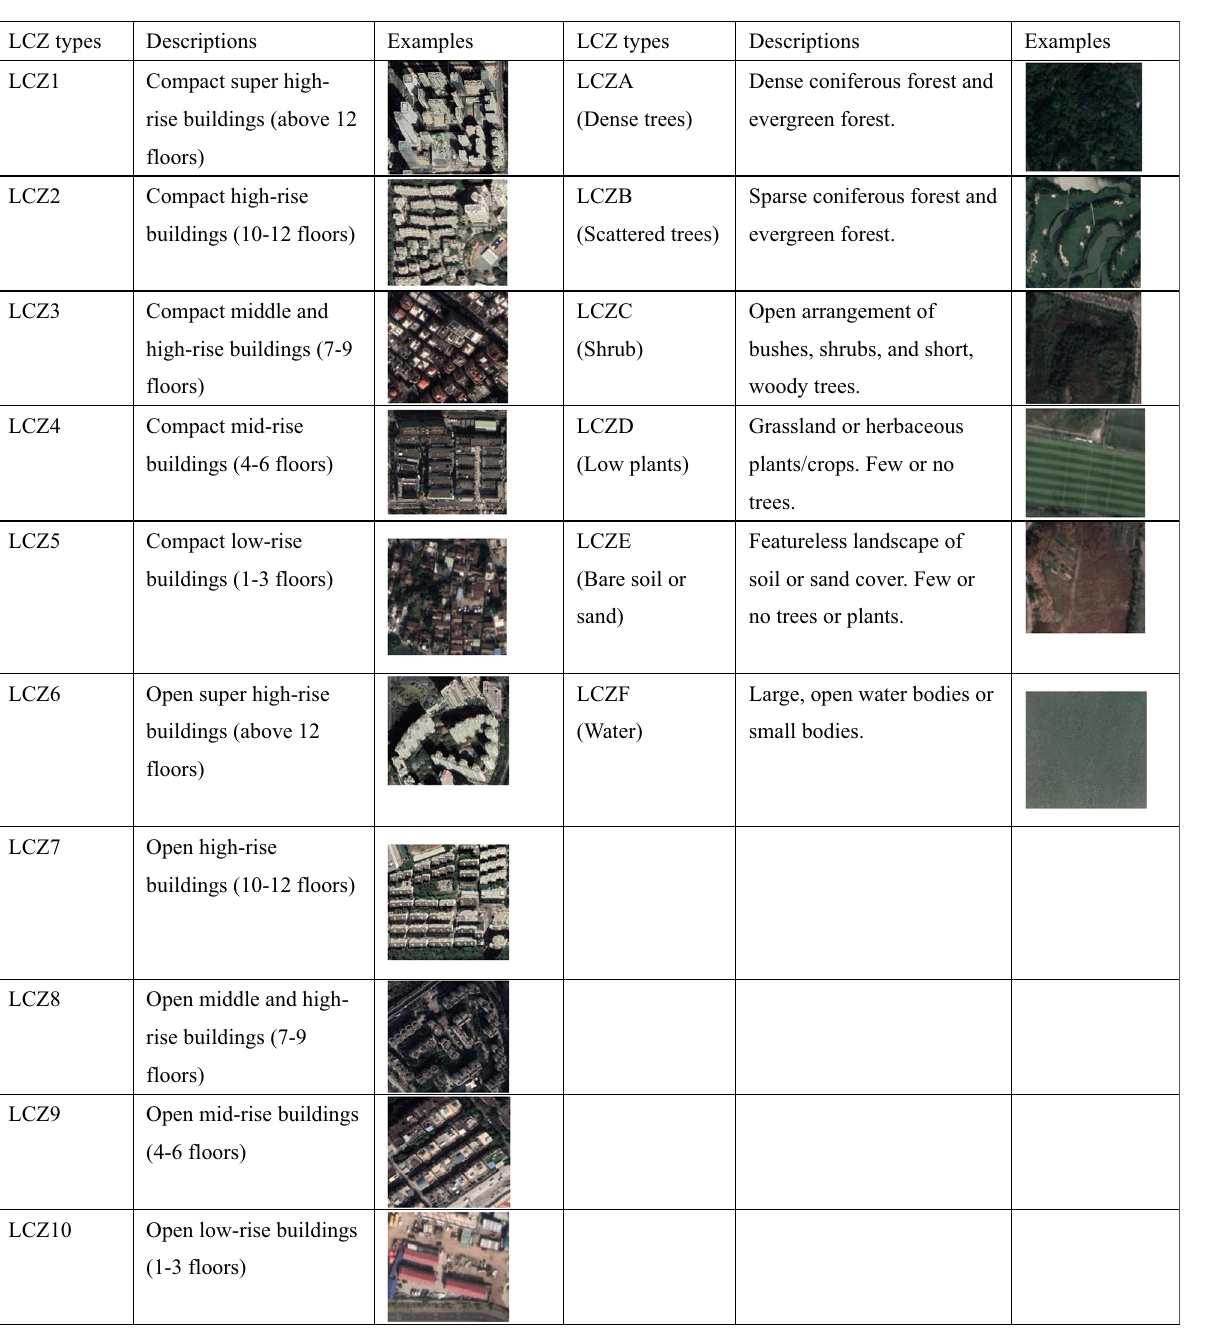
Table 5. De fi nition and description of each LCZ